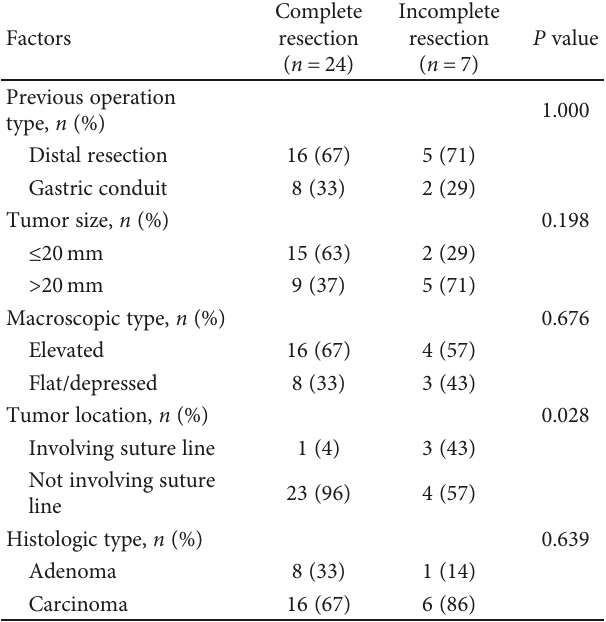
Table 3: Factors for incomplete resection after endoscopic submucosal dissection for gastric epithelial neoplasms in the remnant stomach.